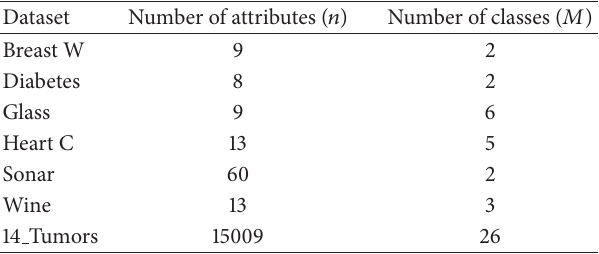
Figure 8: Number of attributes in each dataset. Table 1: Datasets are used in experimental